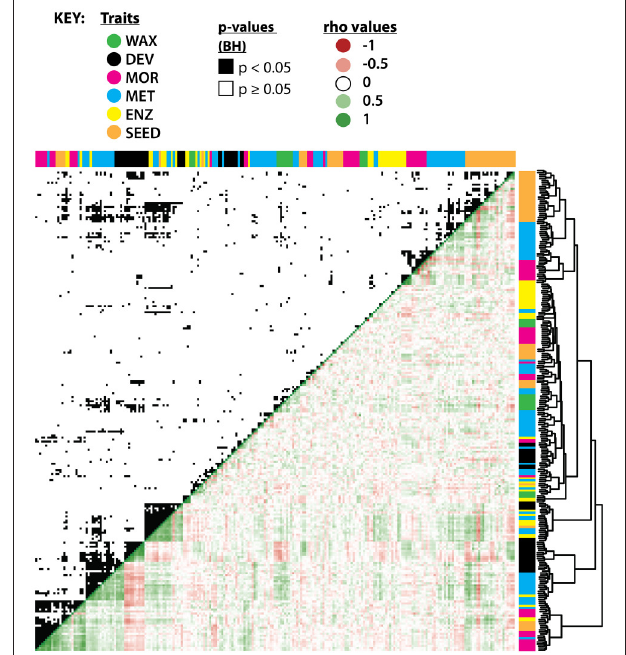
FIGURE 6 | Hierarchical clustering and correlation of leaf wax traits with previously measured IL traits. Hierarchical clustering of leaf wax traits from this study with traits measured in previous studies (see close-up of the hierarchical clustering in Supplemental Figure 3). WAX (green) are leaf wax traits from this study; DEV (black), leaf developmental traits from Chitwood et al. (2013); MOR (pink), entire-plant, yield, and reproductive morphological traits from Schauer et al. (2006, 2008); MET (blue), metabolic traits from the two previous studies; ENZ (yellow), enzymatic activities from Steinhauser et al. (2011); SEED (orange), seed metabolites as measured by Toubiana et al. (2012). Hierarchical clustering is based on absolute correlation values. The upper quadrant shows significant correlations ( p < 0.05) between traits after multiple test adjustment, shown in black. The lower quadrant indicates Spearman’s ρ values in red (negative), white (neutral), and green (positive). The p -values and ρ values used to generate this figure are available in Supplemental Dataset 8.